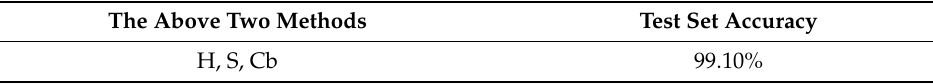
Table 4. Channel attention combined with image